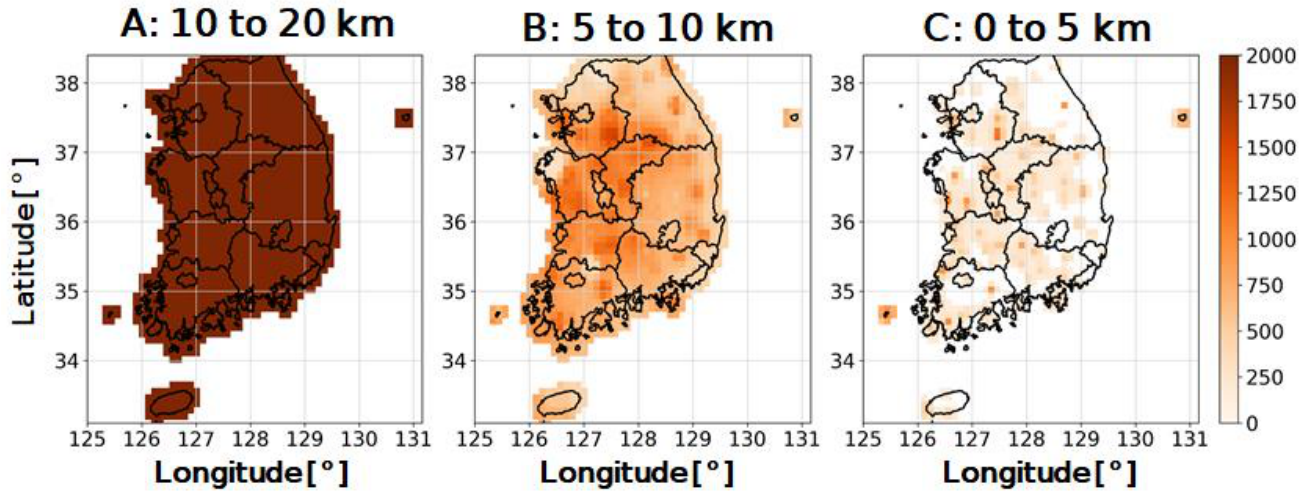
Figure 9. Visibility counts according to visibility ranges ( A – C ) for period from January to October 2021.